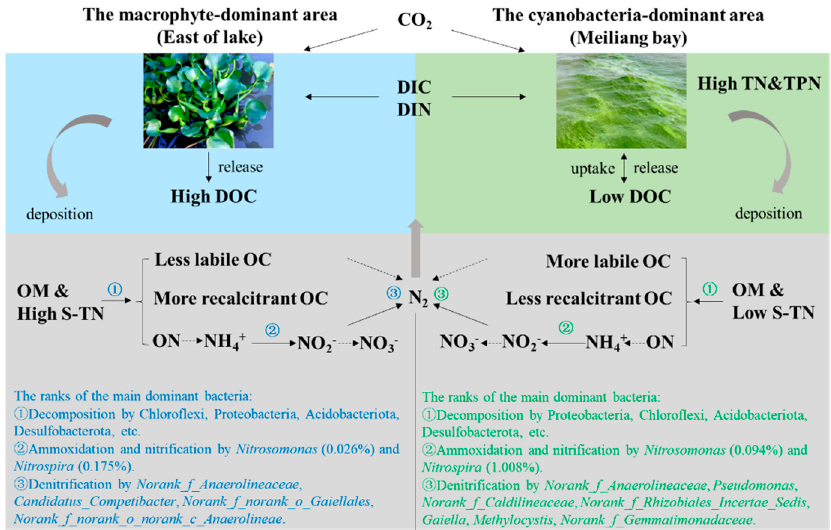
Figure 9. Schematic diagram of C and N migration and transformation driven by cyanobacteria and macrophyte activities.